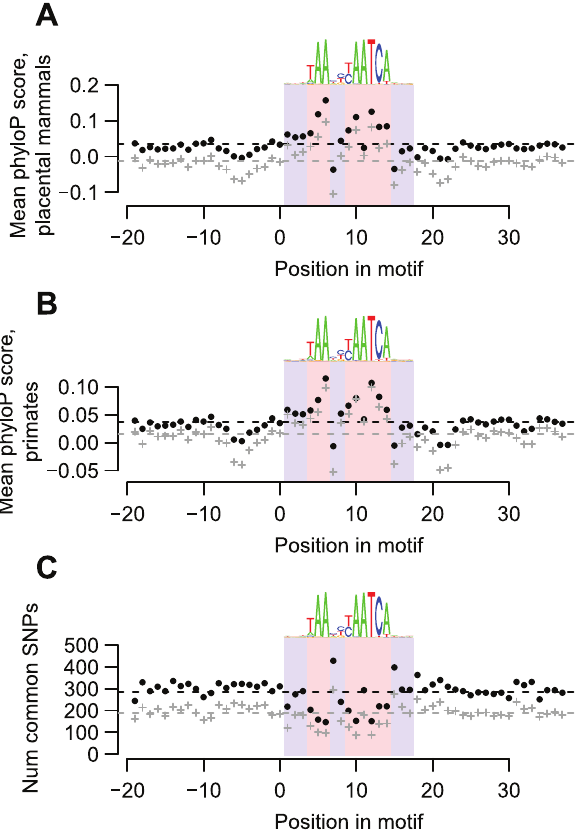
Figure 2. DUX4-bound motifs are evolutionarily conserved. (A) DUX4 motifs are conserved among placental mammals. We obtained phylogenetic conservation scores for placental mammals (phyloP scores) via the UCSC genome browser for the top-scoring DUX4 motif in each of the 63,795 DUX4 ChIP-seq peaks, along with scores for 20 bp flanking regions on each side. For each position in the motif, we show the mean phyloP score across all 63,795 motifs (black datapoints) or across just motifs overlapping repetitive elements (gray datapoints). The dashed lines show overall mean scores for the entire motif plus their flanking regions. We use blue and red background shading to indicate the 17 nucleotide positions that comprise the DUX4 motif, with light red shading showing the least variable nucleotide positions of the motif. A sequence logo of the motif is shown above each graph. It is clear that most of the nucleotide positions that are least variable in the DUX4 motif have higher conservation scores than the surrounding positions. (B) DUX4 motifs are conserved among primates. Primate phyloP scores, plotted as in panel A. (C) Common SNPs are under- represented in DUX4-bound motifs. We used the UCSC genome browser to determine the locations of common SNPs ( $ 1% minor allele frequency) within any of the 63,795 DUX4-bound motifs and their flanking regions. We plot the number of SNPs found at each position in any of the 63,795 DUX4-bound motifs (black datapoints), or in just motifs overlapping repetitive elements (gray datapoints). It is clear that there are fewer SNPs in most of the nucleotide positions that are least variable in the DUX4 motif than in the surrounding positions.